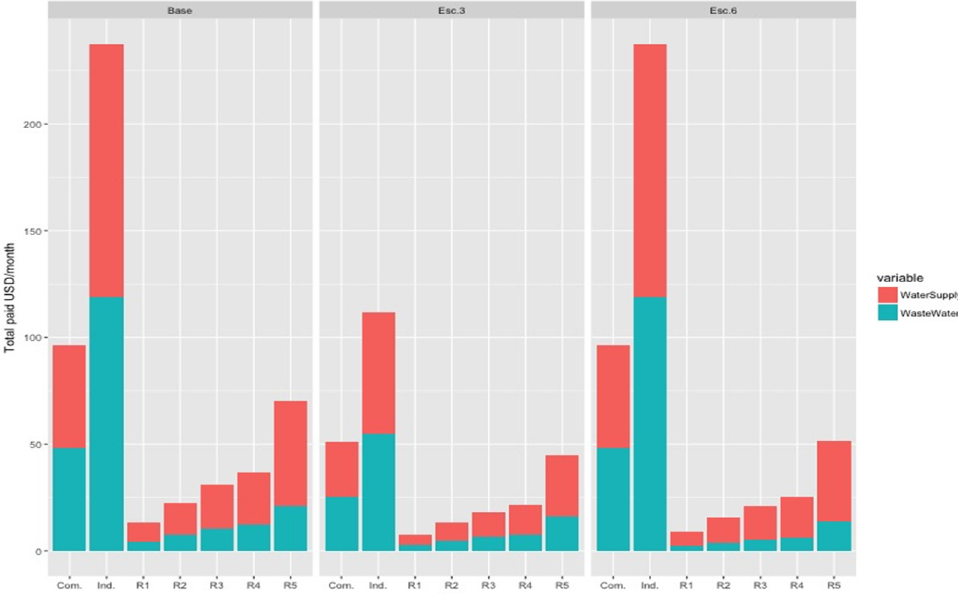
Figure 6 Comparison of the cost for services in the baseline and scenarios 3 and 6 for the Fucha Catchment.